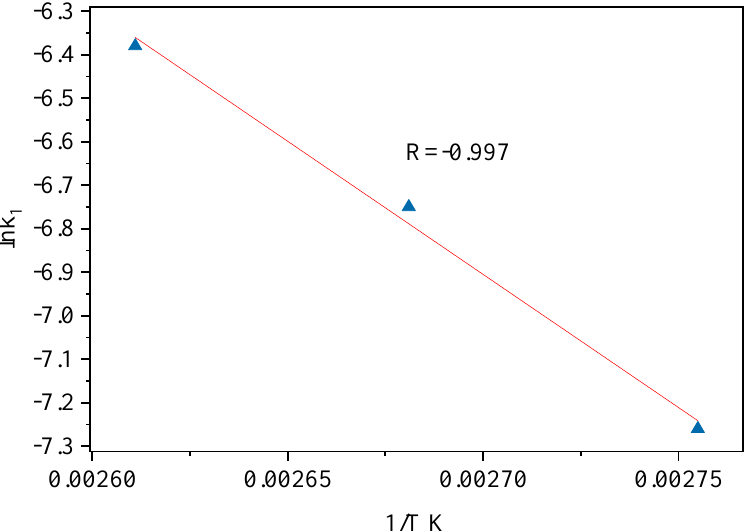
Figure 11. ln k 1 – T − 1 relationship for Ni leaching.